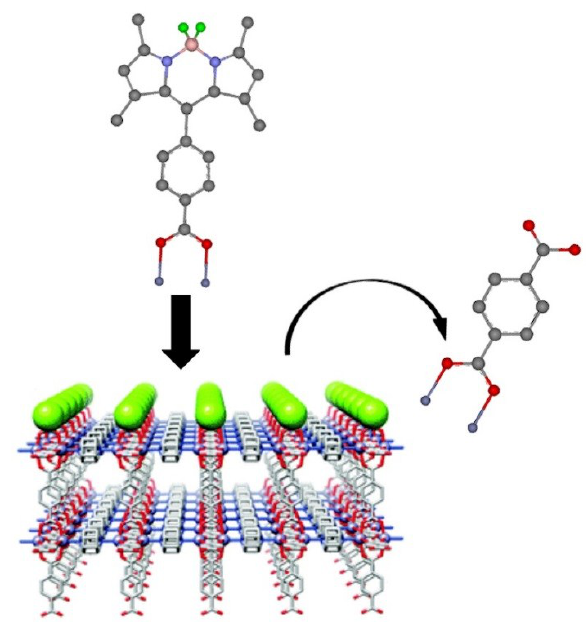
Figure 12. Exchange of surface ligands, 1,4-benzenedicarboxylate units (1,4-bdc) by the fluorescent boron dipyrromethene linkers. (Colour scheme: Zn, purple; O, red; B, pink; Co, yellow; C, dark grey; N, blue; F, green).